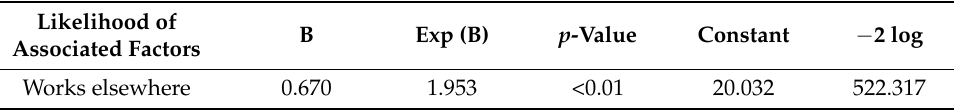
Table 4. Binary logistic regression analysis of the association between lifestyle and work variables of health workers participating in the study. Likelihood of Associated